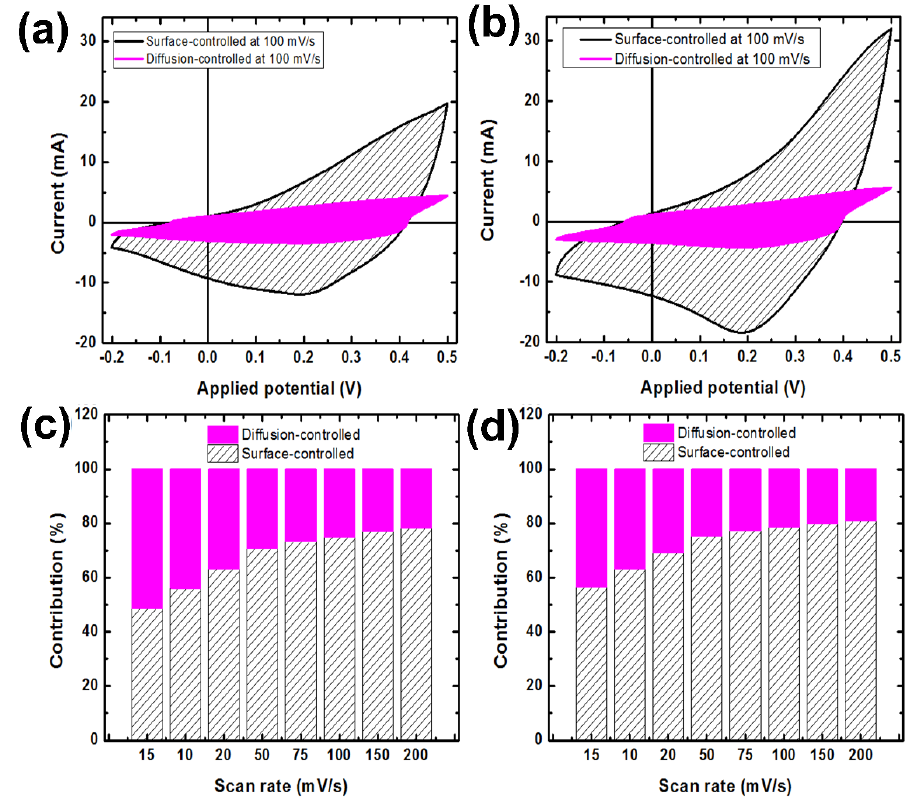
Figure 9. Typical CV curves and contribution of the different mechanisms on the capacitive behavior of the Co x NiV y O z electrode deposited on the ( a , c ) Ni foam and ( b , d ) Ni foam@rGO substrates. The current density of the coated electrode on Ni foam@rGO substrate is greater than for the prepared sample on the Ni foam substrate at the same scan rates. Because of the increased conductivity and supercapacitive behavior of interlaced petal-like Co x NiV y O z nanosheets in the presence of a conducting rGO layer, the obtained CV curves of the coated electrode on Ni foam@rGO show an area at all scan rates greater than for the sam- ple coated on bare Ni foam. According to the BET plots of substrates (Figure S2, Support- ing Materials), the specific surface area of resultant NiO@rGO substrate became much larger than of the pure Ni foam substrate. The greater energy-storage capacity can be at- tributed to the growth of Co x NiV y O z -crochet nanosheets on a rGO coated surface with increased surface area, and randomly distributed nanosheets across the surface of the coated electrode on the Ni foam@rGO substrate (Figure 5a), which easily connect the inner surface area with the outer electrolyte. This structure hence facilitates rapid ion intercala- tion and extraction. The electrochemical tests led to volumetric changes of the layers, as monitored by FESEM and FTIR analysis. The FESEM images (Figure 10) of electrodes before and after electrochemical tests show that the microstructure and morphology of the petal-like Co x NiV y O z nanosheets were modified during the electrochemical tests. The modified structures had absorption of electrolyte ions, causing a decreased specific capacitance af- ter undergoing consecutive CV scans.